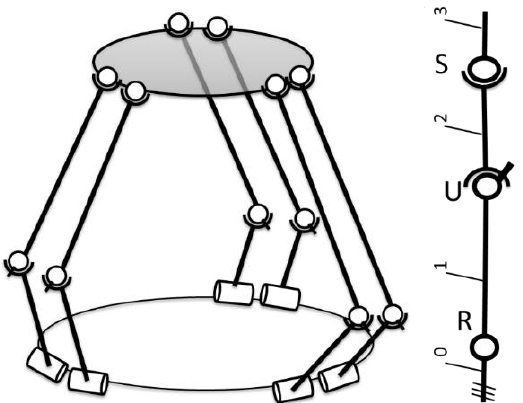
Figure 3. Parallel robot composed of 6 identical RUS open loops (adapted with permission from ref. [23]. 2022, IEEE Proceedings).